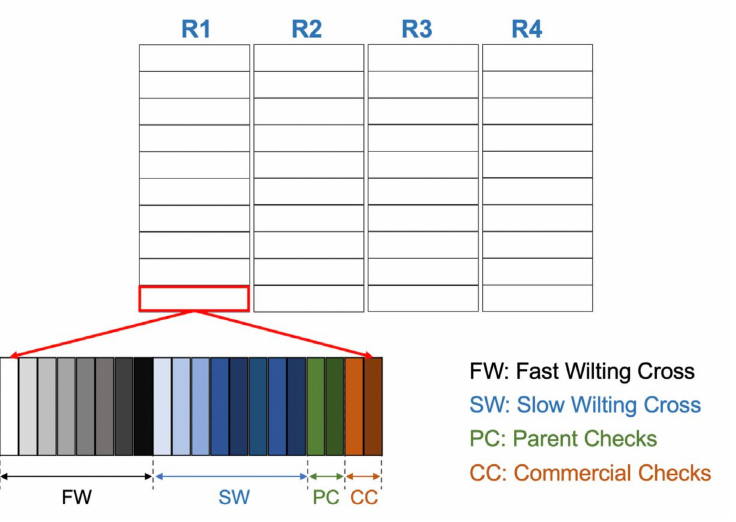
Figure 1. Experimental design. R1, R2, R3, and R4 are the strips of irrigation onset. The plots were 4.6 m long with 1.5 m alley, and consisted of two rows 0.97 m apart in 19ROH and 20ROH, and 0.91 m apart in 19STU and 20STU. The planting date